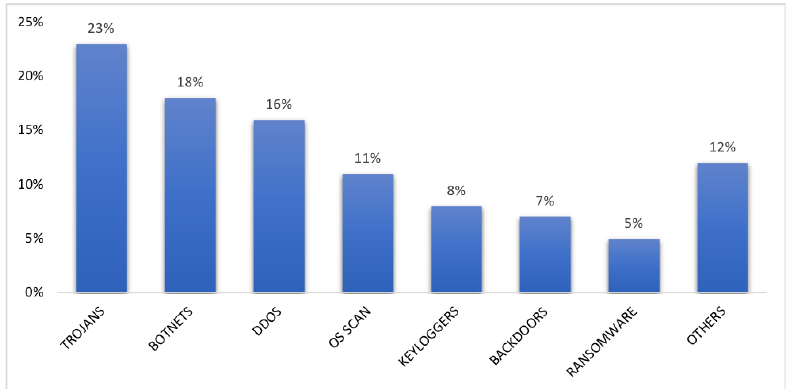
Figure 5. Malicious traffic samples percentage according to the type of malware.